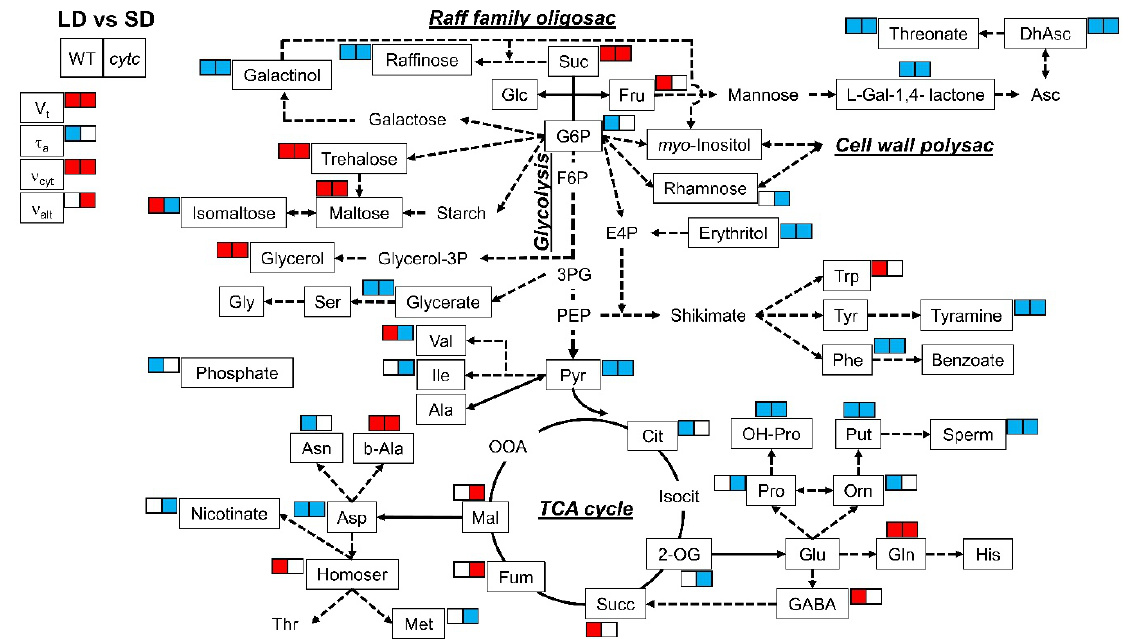
Figure 3. Metabolic model showing comparisons of leaf primary metabolites and respiratory parameters between LD and SD in WT and cytc mutants. Colored metabolites are those showing to be significantly ( p < 0.05) higher (red) or lower (blue), determined by Duncan’s test. For cytc mutants, highlighted metabolites are those displaying consistent changes between photoperiods in both mutant lines. Data used were taken from Figure 2 and Table 2. Suc, sucrose; Glc, glucose; Fru, fructose; G6P, glucose-6-phosphate; F6P, fructose-6-phosphate; E4P, erythrose-4-phosphate; 3PG, 3-phosphoglycerate; PEP, phosphoenolpyruvate; Pyr, pyruvate; Cit, citrate; Isocit, isocitrate; 2-OG, 2-oxoglutarate; Succ, succinate; Fum, fumarate; Mal, malate; OOA, oxaloacetate; Asp, aspartate; Asn, asparagine; Thr, threonine; b-Ala, beta-alanine; Homoser, homoserine; Met, methionine; Val, valine; Ile, isoleucine; Ala, alanine; Ser, serine; Gly, glycine; Glycerol-3P, glycerol-3-phosphate; Glu, glutamate; Gln, glutamine; His, histidine; GABA, gamma-aminobutyrate; Pro, proline; OH-Pro, 4-hydroxy-proline; Orn, ornithine; Put, putrescine; Sperm, Spermine; Trp, tryptophan; Tyr, tyrosine; Phe, phenylalanine; L-Gal-1,4-lactone, L-galactono-1,4-lactone; Asc, ascorbate; DhAsc,